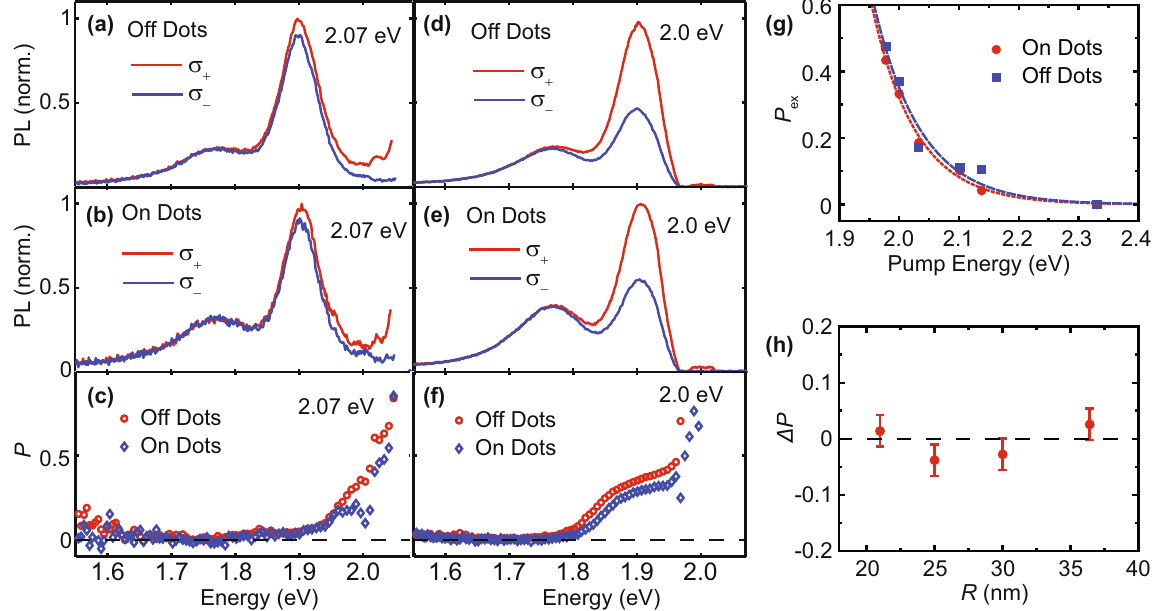
Figure 4. Valley polarization characterization from a continuous ML and nanodots. ( a , b ) Circularly-polarized emission with pump energy of 2.07 eV. ( c ) Polarization P of PL with pump energy of 2.07 eV. ( d , e ) Circularly polarized PL with pump energy of 2.00 eV. ( f ) Polarization P with pump energy 2.00 eV. ( g ) Pump energy dependence of the continuous ML (off dots) and nanodots (on dots). The characteristic energy exponential decay scale is ξ = 74 meV for nanodots (red) and ξ = 79 meV for a continuous ML (blue). ( h ) The negligible change in PL circular polarization with confinement is independent of nanodot size. Polarization is measured with pump energy at 2.00 eV for ( g , h ). PL in this figure is collected at 6